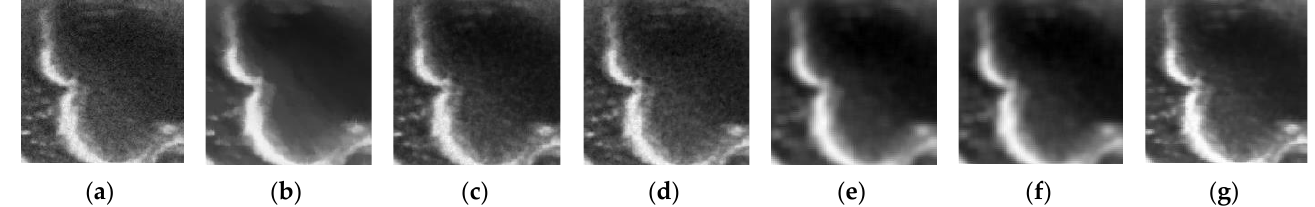
model. ( c ) FTV model. ( d ) AFOTV model. ( e ) F-DSG-NLM model. ( f ) FNM model. ( g ) Our model.